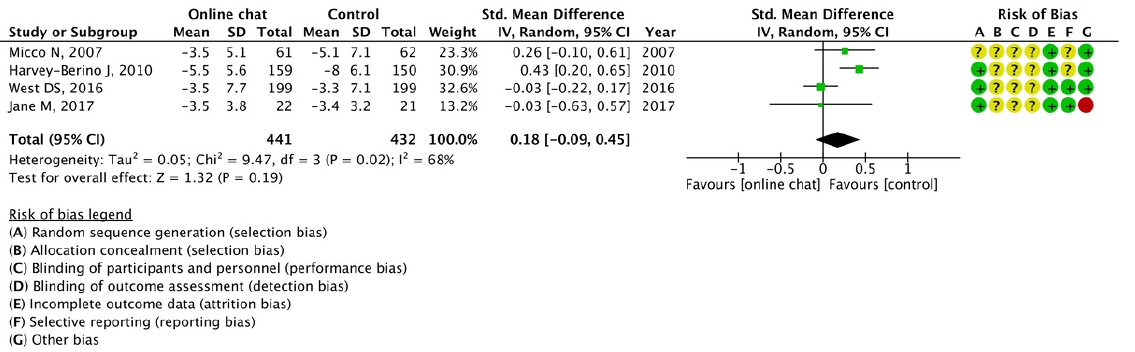
Figure 7. Meta-analysis for mean weight change with or without chatting online using 4 articles [18,21,48,51]. The forest plot shows standardized mean differences (SMD) for each article with 95% confidence intervals (CI). The diamond at the bottom of the graph means the meta-analyzed measure of effect and the lateral points of which indicate CIs for this estimate. A negative value reflects web-based interventions with online chat aren’t more effective for weight loss than web- based interventions without online. The area of each green square is proportional to the study's weight in the meta-analysis.